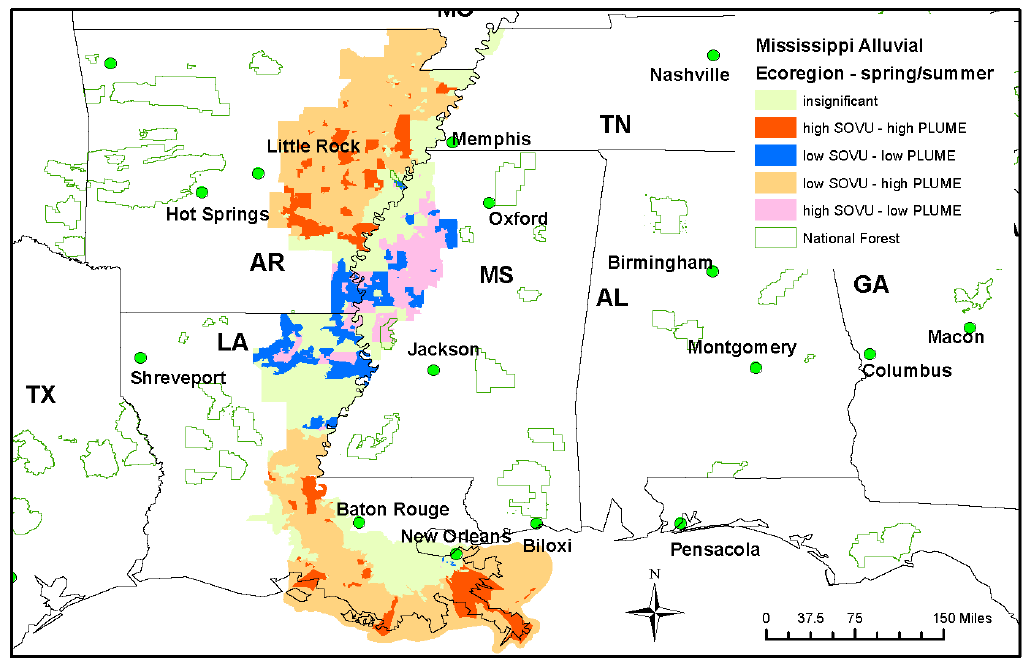
Figure 11. Bivariate LISA mapping of social vulnerability and smoke plume in the Mississippi-Alluvial